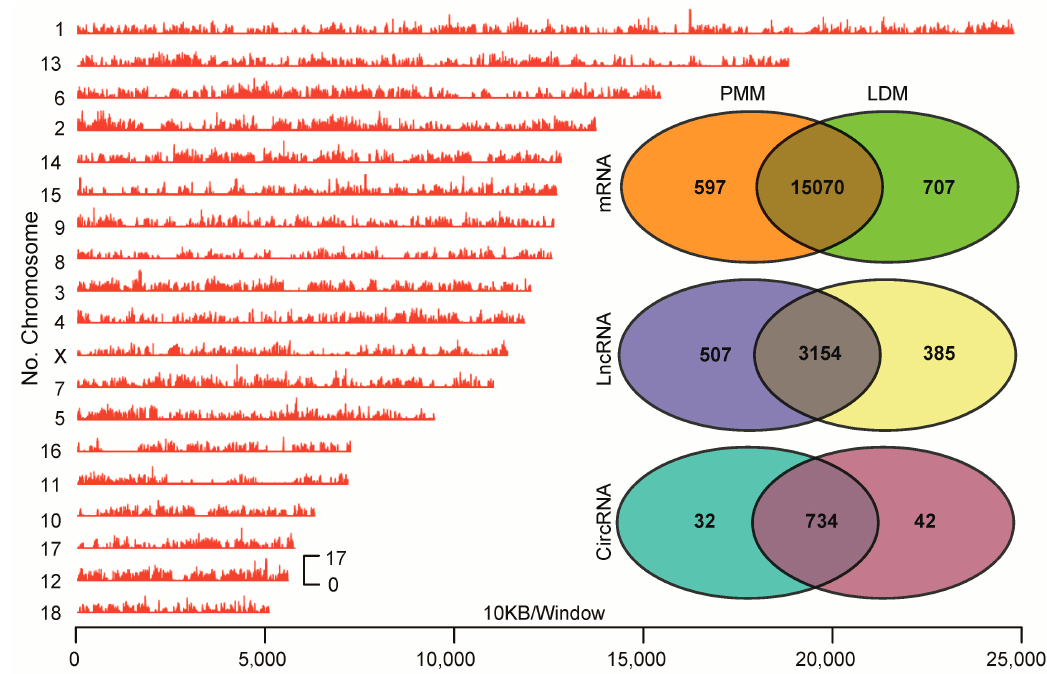
Figure 3. The distribution of sequenced reads and expressed transcripts in muscles. The left panel represented genome-wide distribution of sequenced reads in pig chromosomes. The right panel of Venn diagrams represented all the numbers of expressed mRNAs, lncRNAs, and circRNAs between LDM and PMM.